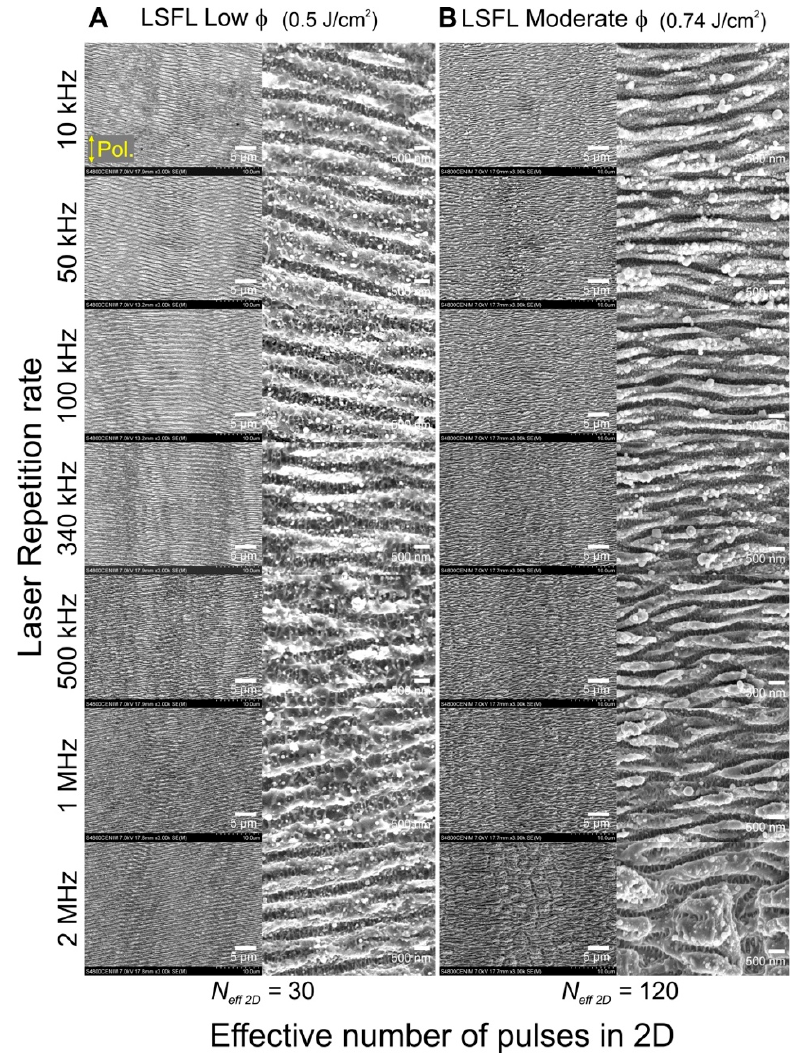
Figure 5. Areas irradiated on steel 1.7225 at different laser repetition rates. The structures shown are organized in two vertical sets (and two different magnifications) corresponding to LSFL at low ( A ) and moderate ( B ) fluences. Each set of structures is produced at a fixed laser fluence ( ϕ ) and a constant number of effective pulses per spot unit in 2-dimensions ( N eff 2D ) indicated at the bottom of each structure set. The laser beam polarization is indicated by the yellow double arrow in the top left SEM micrograph. The laser scanning direction is parallel to this direction.